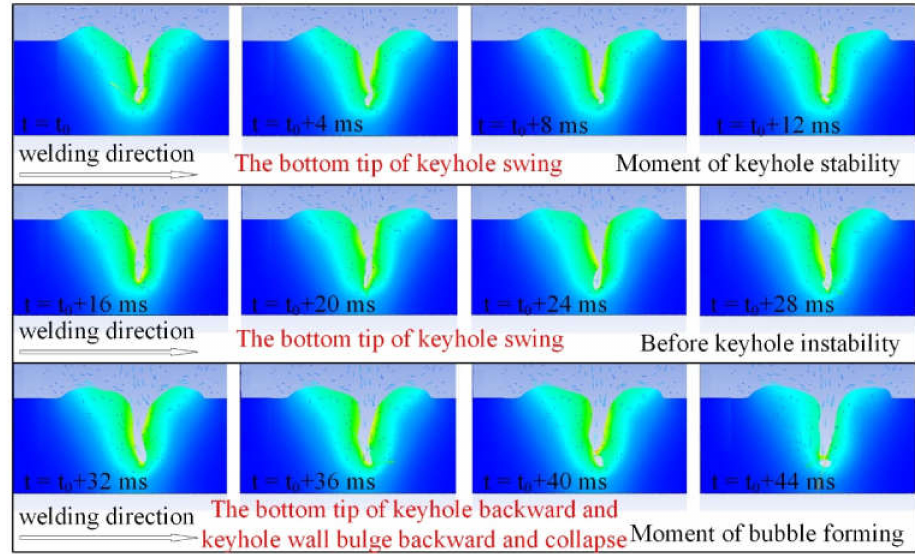
Figure 15. Bubble formation process caused by bulge and collapse of keyhole front wall.